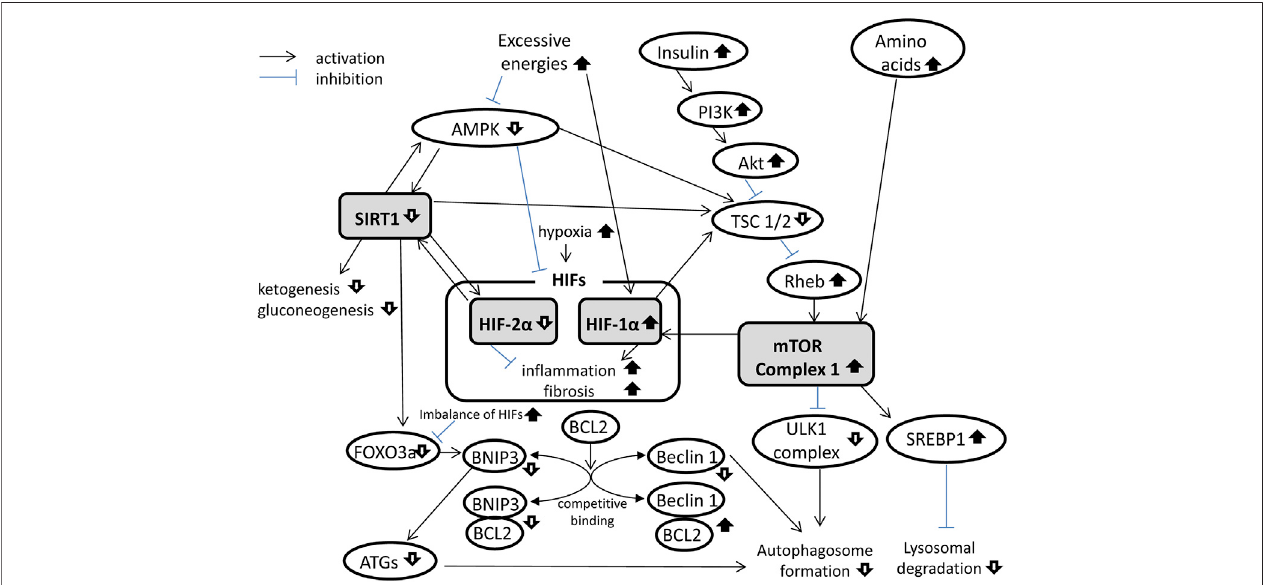
FIGURE 1 | Mammalian target of rapamycin (mTOR), sirtuin 1 (SIRT1), and hypoxia-inducible factor (HIF) signaling pathways in overnutrition diseases. mTOR complex 1 (mTORC1) formation is activated, whereas SIRT1 is suppressed, and HIFs are imbalanced in overnutrition diseases. These signaling pathways interact with each other and suppress the autophagy fl ux. AMPK, AMP-activated protein kinase; ATGs, autophagy-related genes; BCL2, B-cell lymphoma 2; BNIP3, BCL2- interacting protein 3; FOXO3a, forkhead box O3a; PI3K, phosphatidylinositol-3 kinase; Rheb, Ras homolog enriched in brain; SREBP1, sterol regulatory element – binding protein 1; TSC, tuberous sclerosis complex; ULK1, Unc-51 – like autophagy-activating kinase